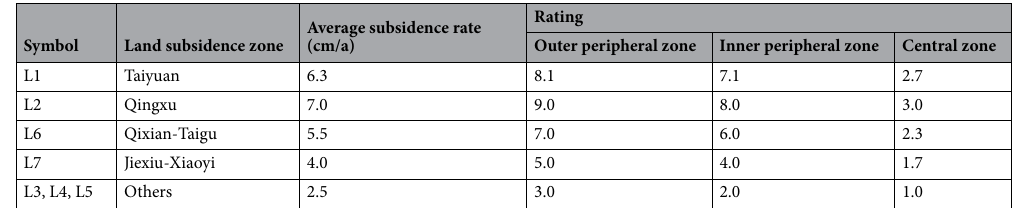
Average subsidence rate